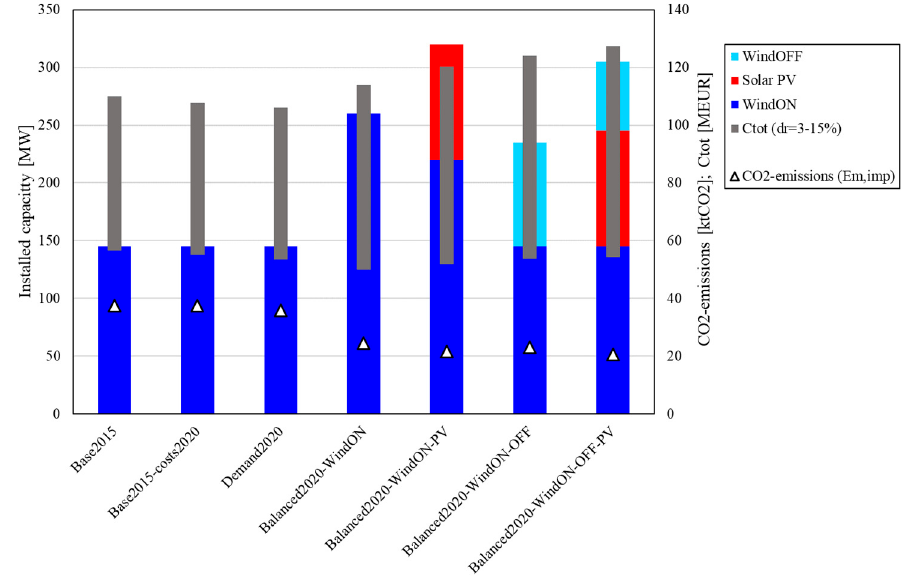
Figure 2. Selected reference scenarios simulated in EnergyPLAN for the Piteå municipal energy system; p el = 40 EUR/MWh, p bio = 35 EUR/MWh.